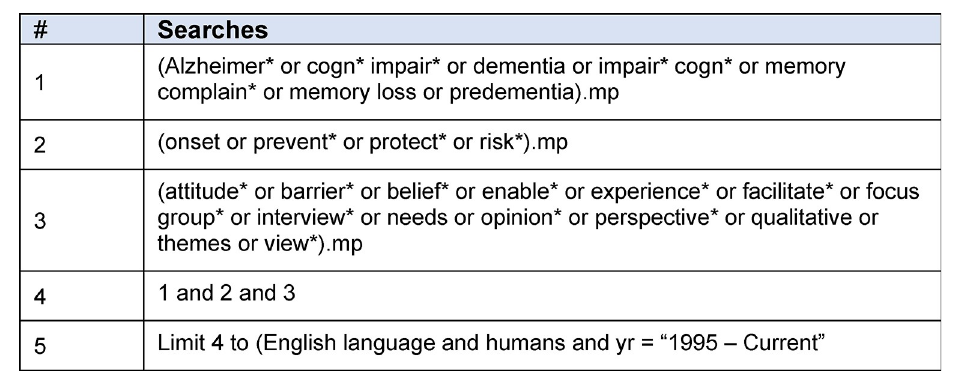
Fig 2. Example search strategy. Search string used for MEDLINE